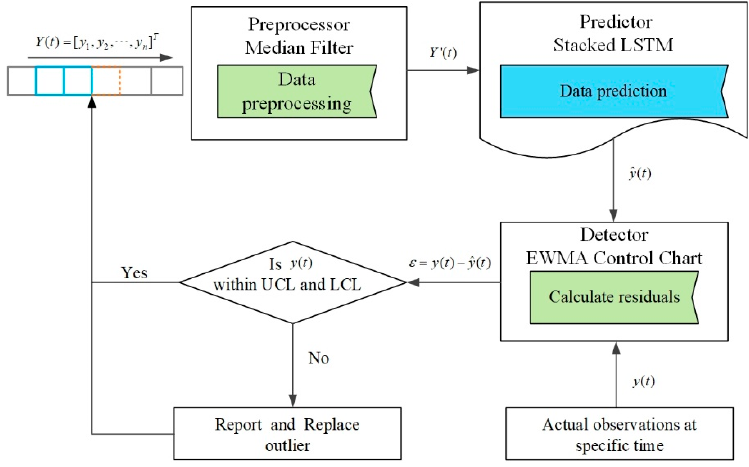
Figure 1. Framework of the proposed approach.